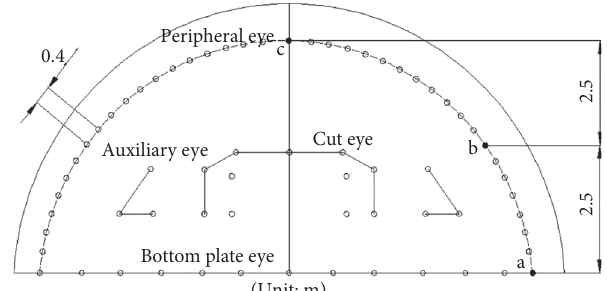
Figure 2: Sectional blasthole layout map.